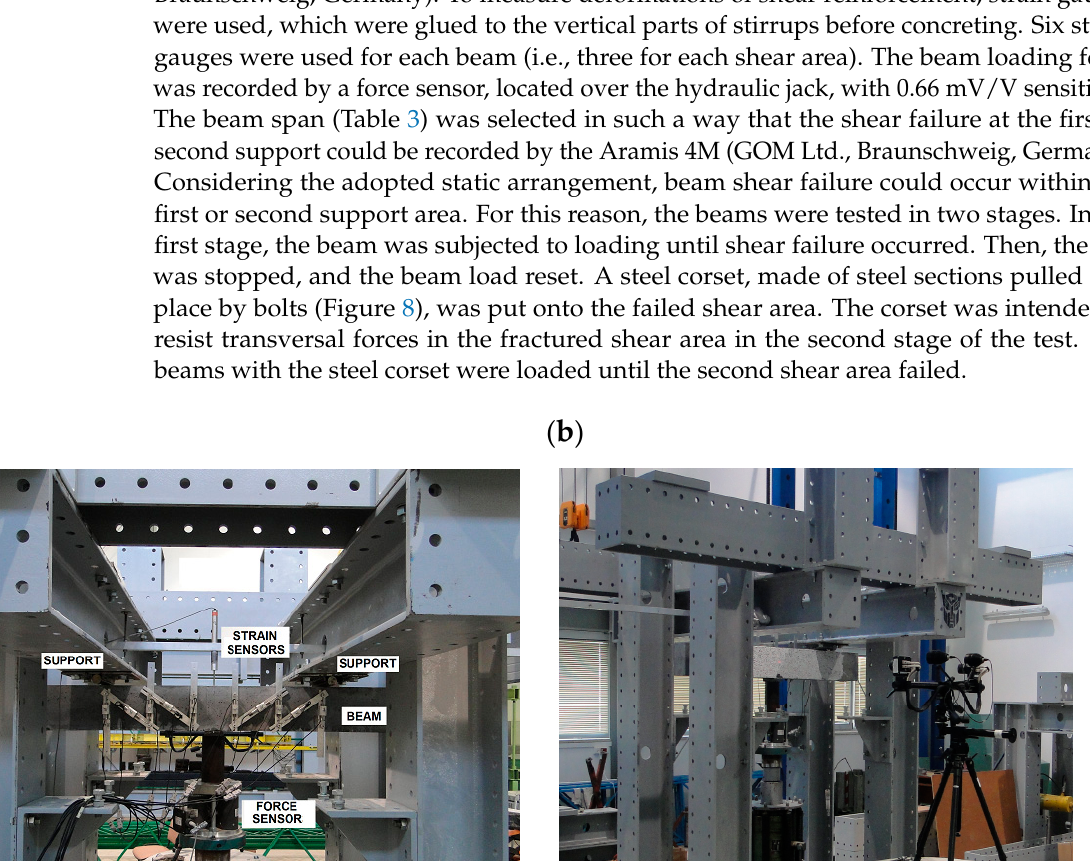
Figure 7. Stand for shear capacity testing of bend elements: ( a ) Beam side surface tested using SAD-256 system; and ( b ) beam side surface tested using Aramis 4M system [44].